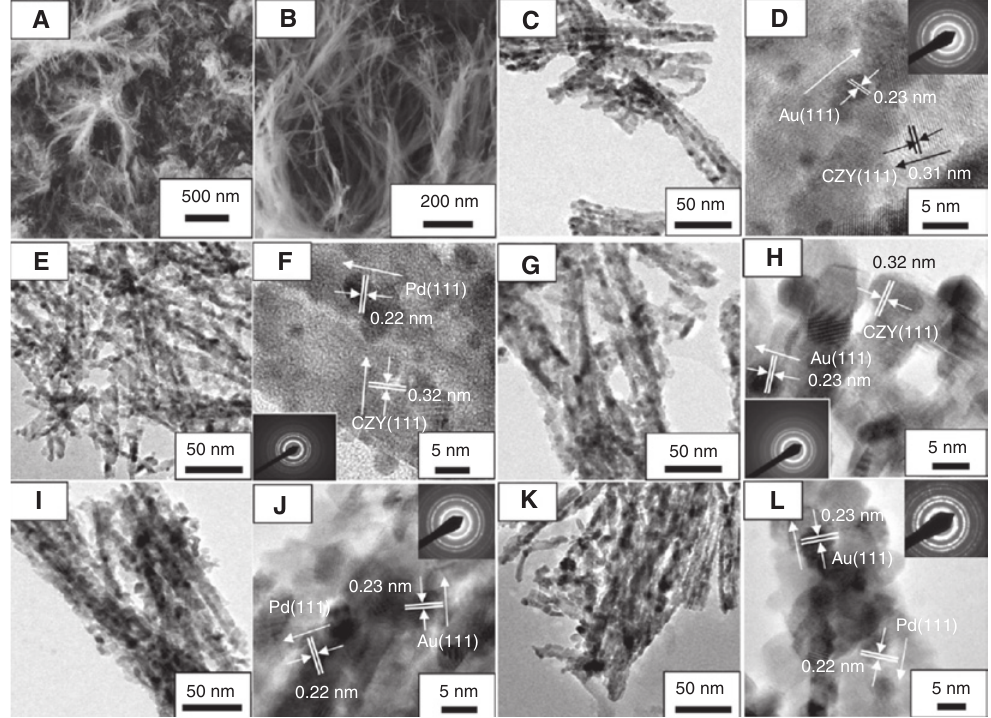
Figure 21: (A, B) SEM and (C–L) TEM images as well as SAED patterns (insets) of (A, B) CZY, (C, D) 0.90 wt.% Au/CZY, (E, F) 0.80 wt.% Pd/ CZY, (G, H) 0.93 wt.% Au the Royal Society of